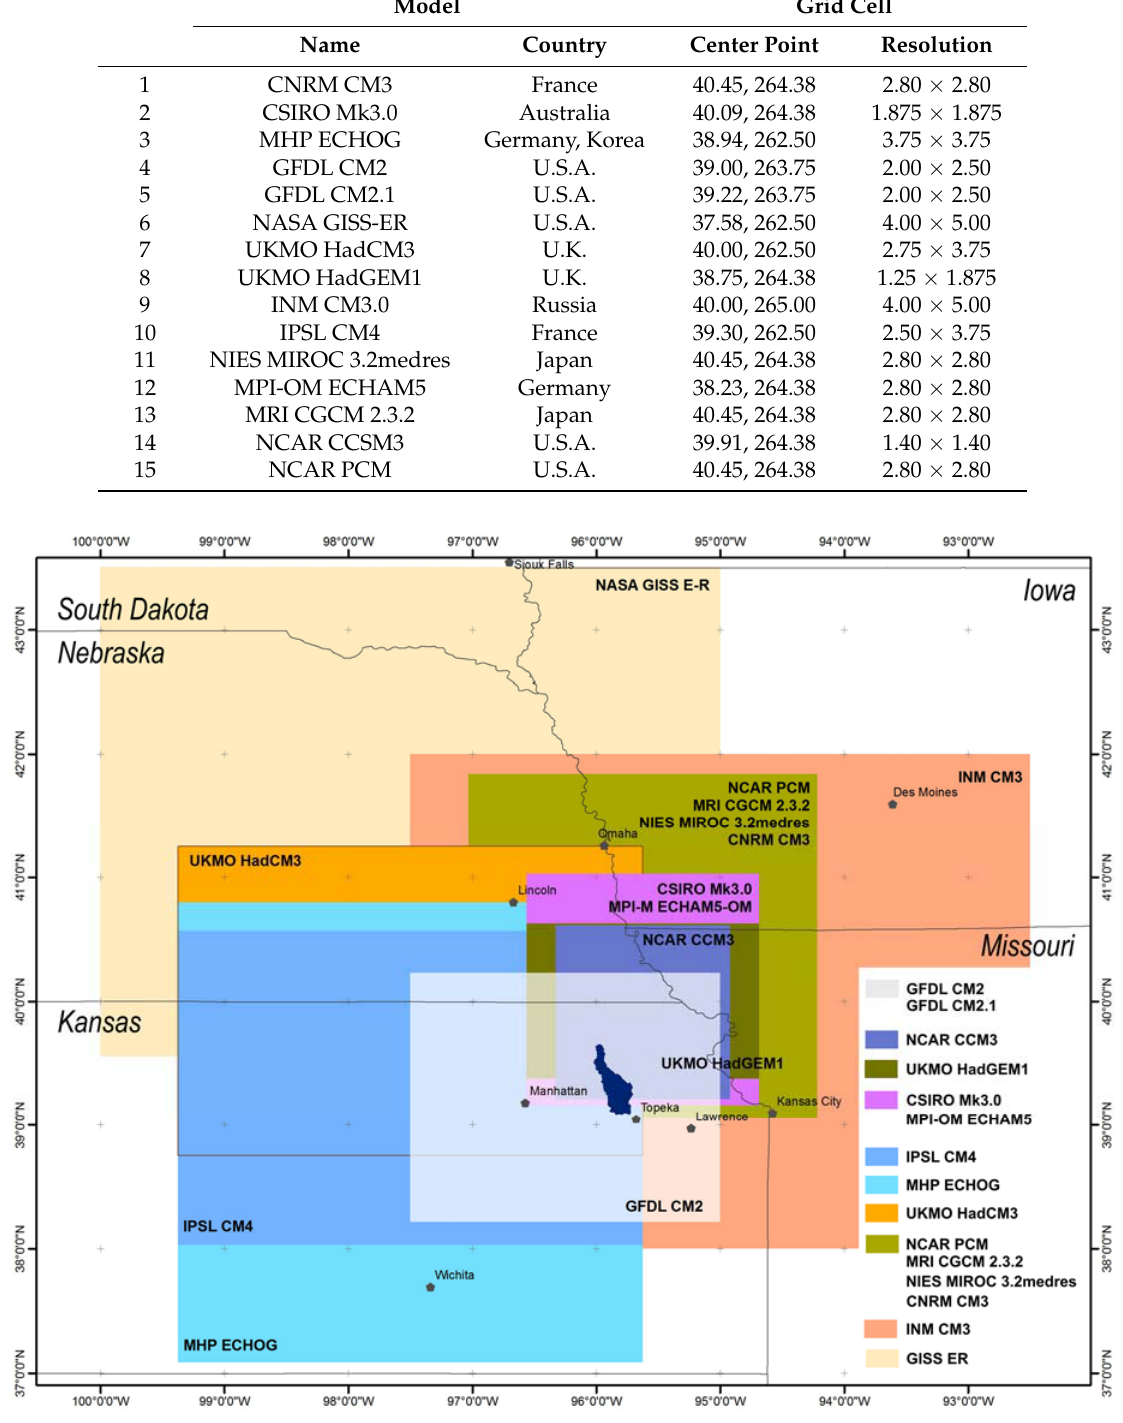
Figure 2. Single grid-cells of 15 General Circulation Models (GCMs) (see Table 1) used for climate data analysis of the Soldier Creek watershed in northeast Kansas.